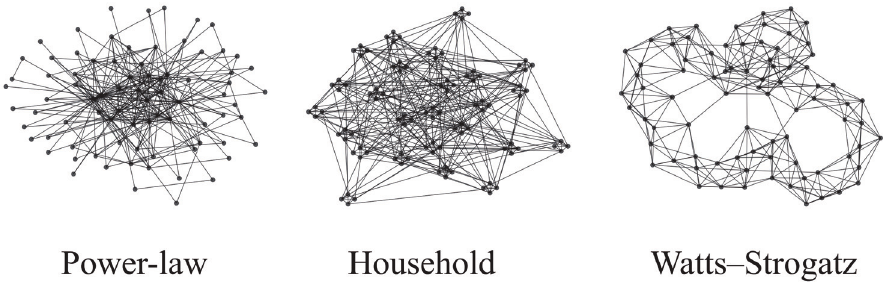
Fig 4. Schematic visualizations of random graph models with 80 nodes and k mean =